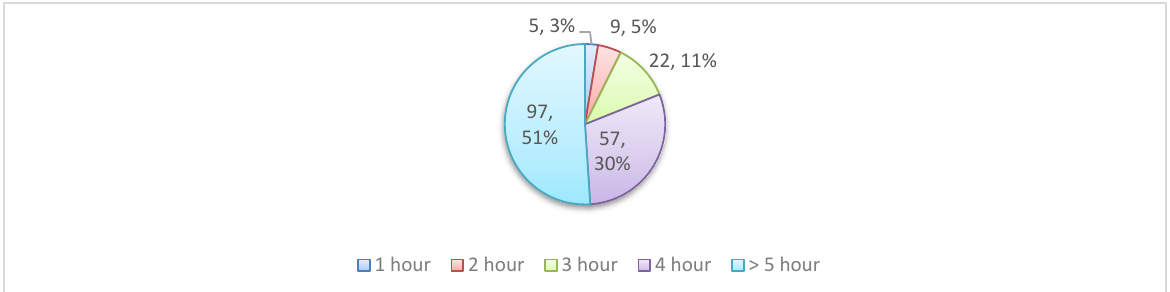
Fig. 1 Result of the usage of social media per day